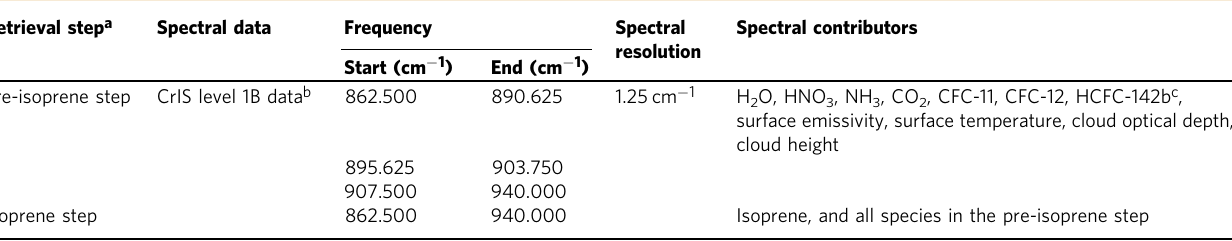
Table 1 Spectral regions used in the pre-isoprene and isoprene retrieval steps Retrieval step a